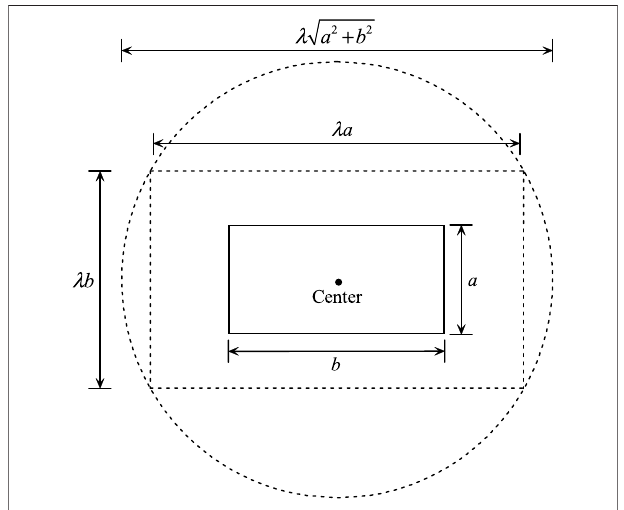
FIGURE1| Geometry ofcircularand rectangularvirtual boundaries fora simple rectangular